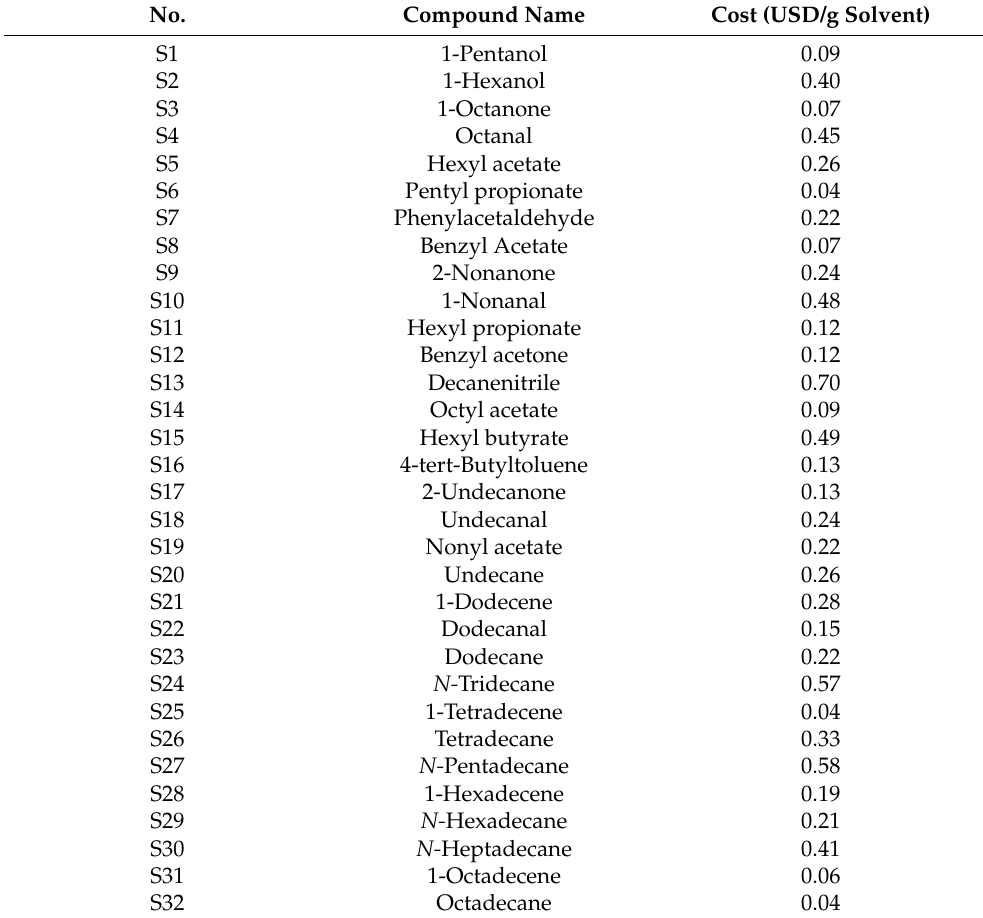
Table A4. Cost of solvent